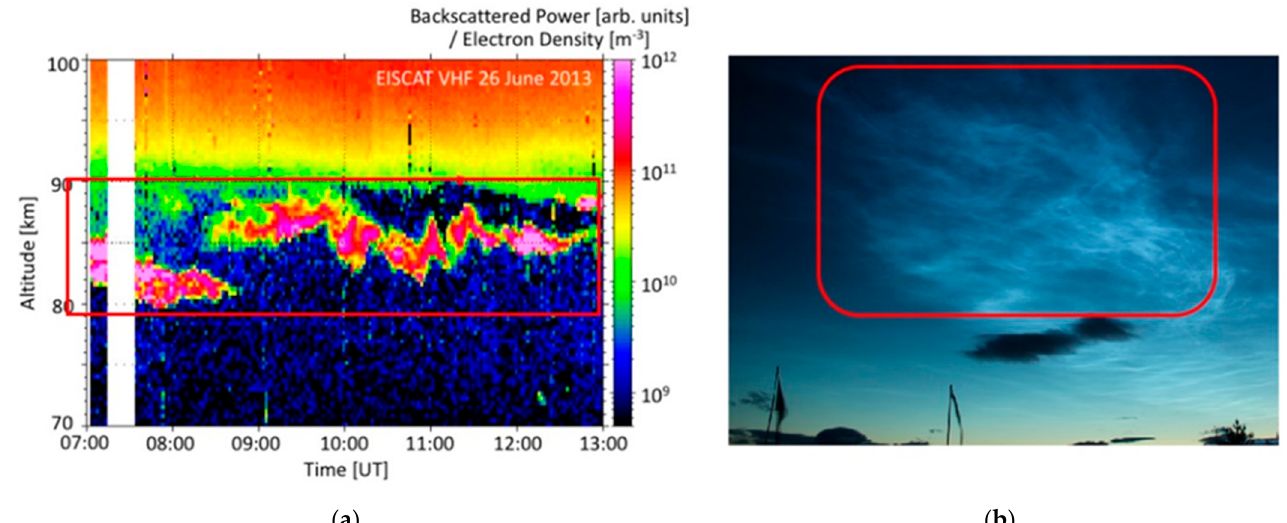
Figure 1. ( a ) The PMSE radar echoes associated with polar ice clouds [11]; and ( b ) optical image consisting of NLC [8]. consisting of NLC